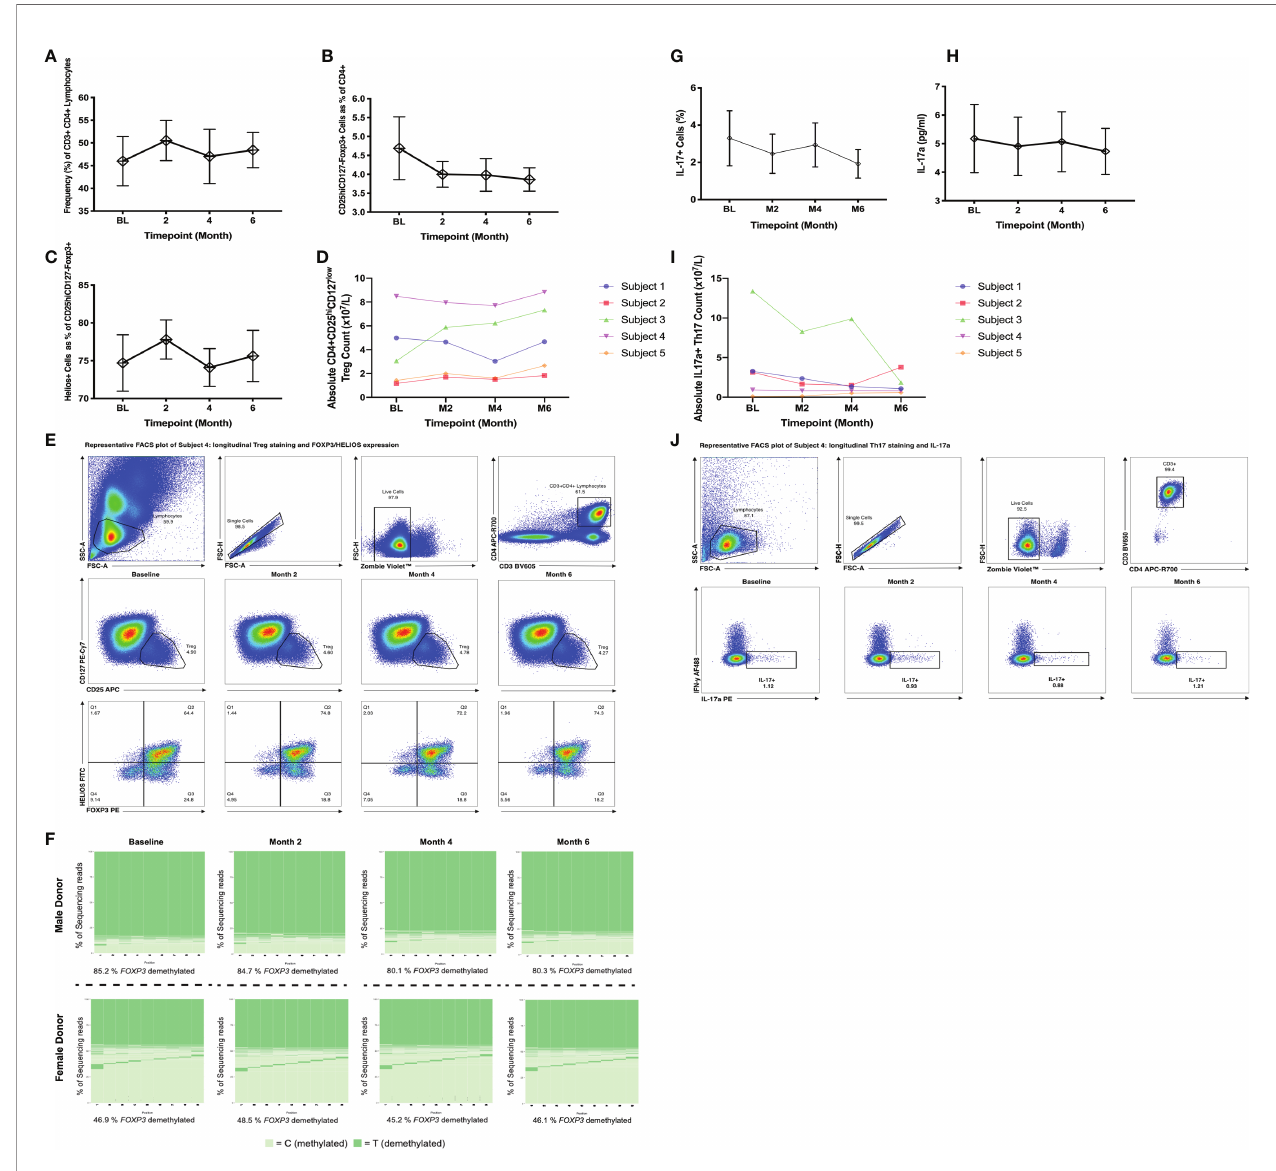
FIGURE 4 | Peripheral blood immune phenotyping of patients randomized to receive bexarotene on the CCMR-One trial. Samples were analyzed at baseline, then at months 2, 4 and 6 following treatment. (A) Frequency of CD3+CD4+ cells as a percent of total lymphocytes. (B) Frequency of CD25hiCD127 − FOXP3+ Tregs as percent of CD4+ cells. (C) Frequency of Helios+ cells as a percent of CD25hiCD127 − FOXP3+ Tregs. Shown are mean values ± SEM, n=5. (D) Absolute Treg counts as de fi ned by CD4+CD25hiCD127low surface phenotype. (E) Representative longitudinal plots of Treg gating and quanti fi cation. FOXP3 and HELIOS expression for these populations are also shown. (F) FOXP3 TSDR methylation of fl ow sorted, circulating CD4+CD25hi CD127low Tregs pre- and post-bexarotene (n=5; two representative donors are shown). (G) Frequency IL-17a+ cells, (H) IL-17a supernatant concentration and (I) absolute Th17 cell counts (as measured by IL-17a positivity). (J) Representative longitudinal plots of intracellular IL17 and IFN- g in CD3+CD4+ cells, from patients pre- and post-bexarotene, following stimulation with PMA + Ionomycin + Brefeldin A. Each sample was run in duplicate. For further information regarding CCMR-One subject demographics, refer to Table 1